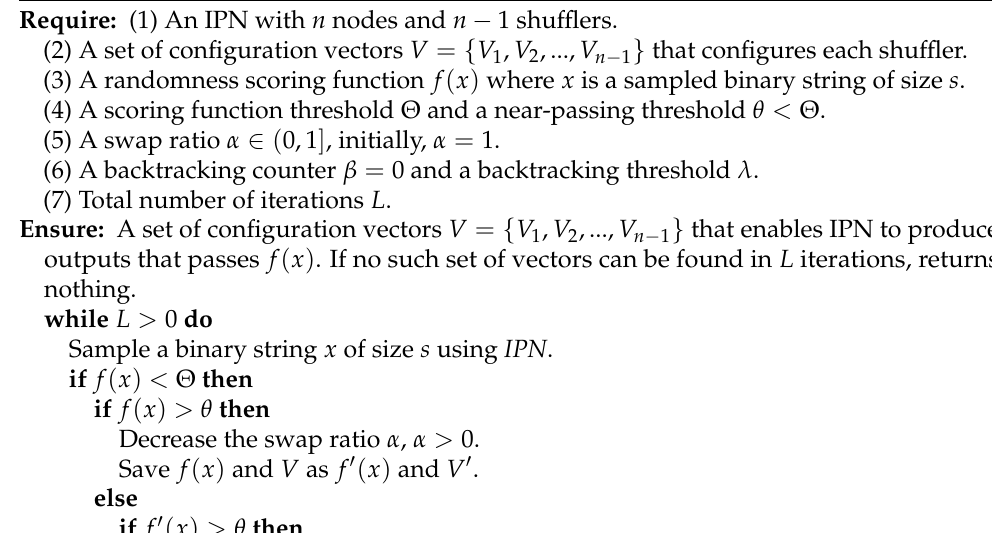
Algorithm 2 Evolution Strategies in